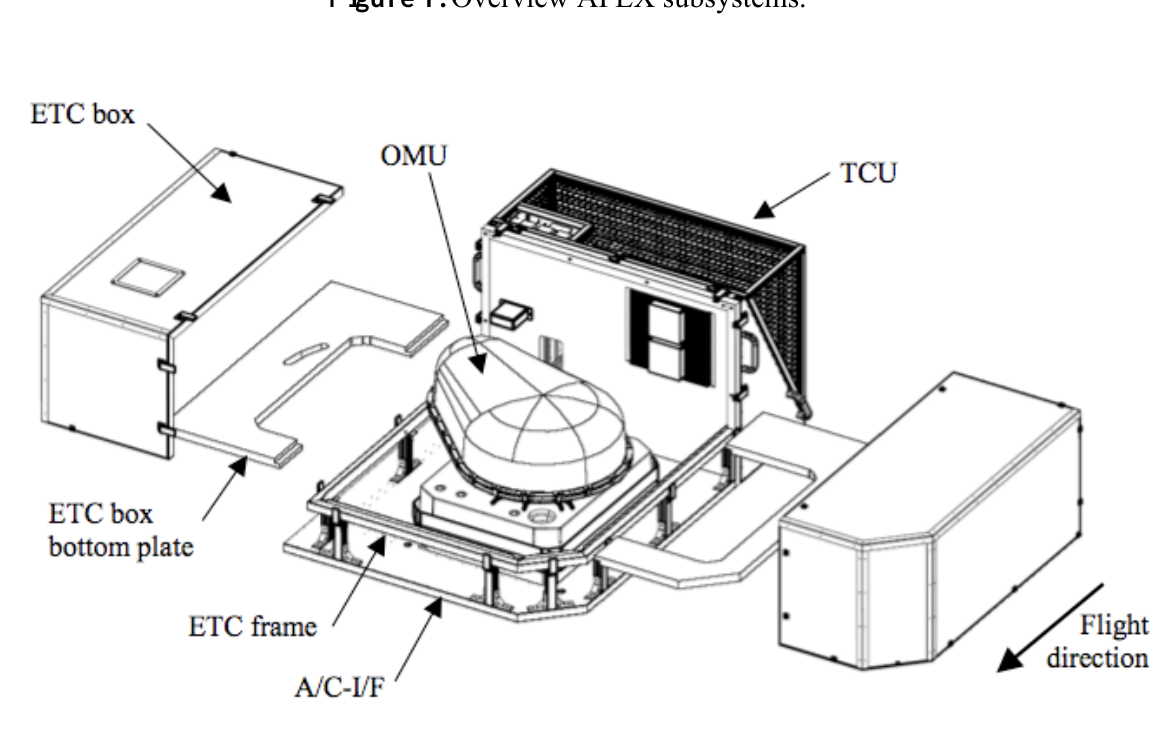
Figure 1. Overview APEX